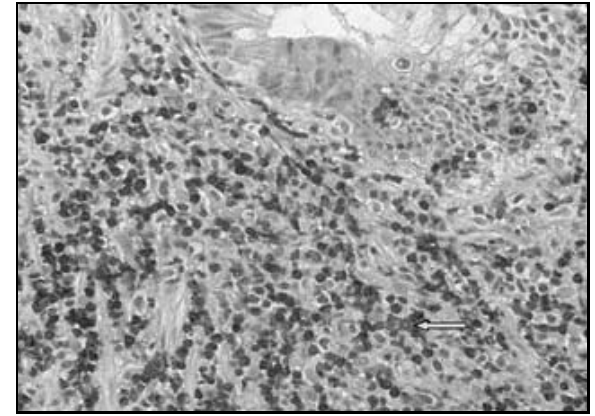
Figura 3 – Expressão da proteína Ki-67 em linfoma de alto grau. Mais de 50% dos núcleos são positivos (Ki-67 400x)